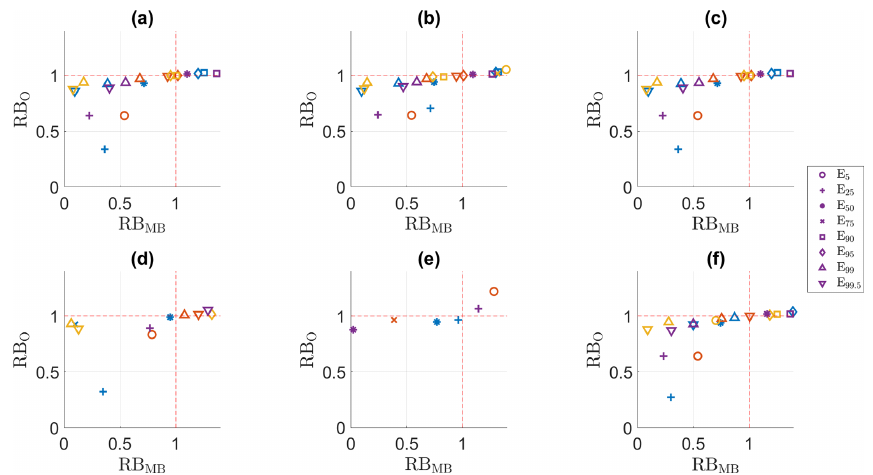
Figure 7. RB MB versus RB 0 for the potential evaporation indices in the validation period. (a) QDM, (b) mQDM, (c) MBCn, (d) MRQNBC, (e) dOTC, (f) R 2 D 2 . Winter: blue, spring: ochre, summer: yellow, autumn: